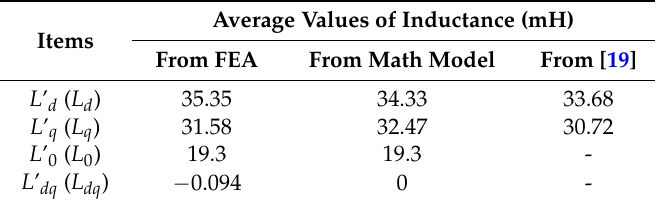
Table 3. Average values of inductance in d-q axes